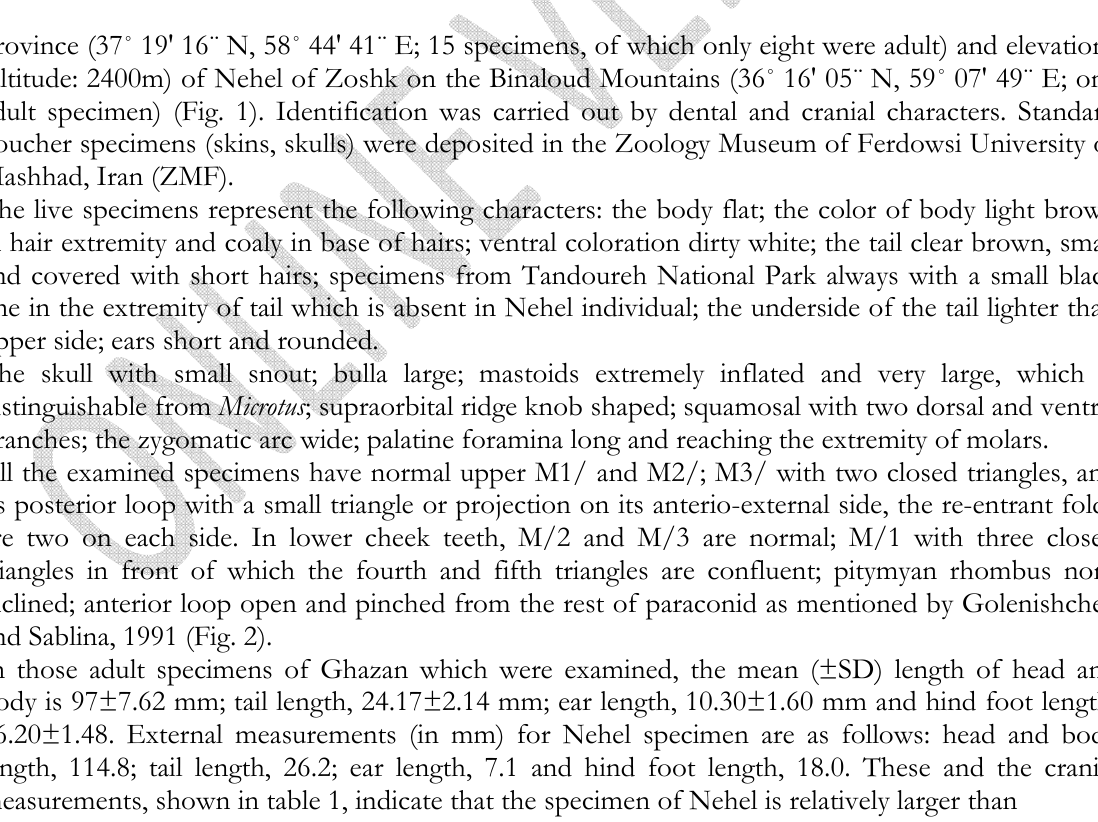
_ Sampling localities of Blanfordimys afghanus in Iran ( ◘ ); and F IG . 1. the type locality of the species in Afghanistan ( ■